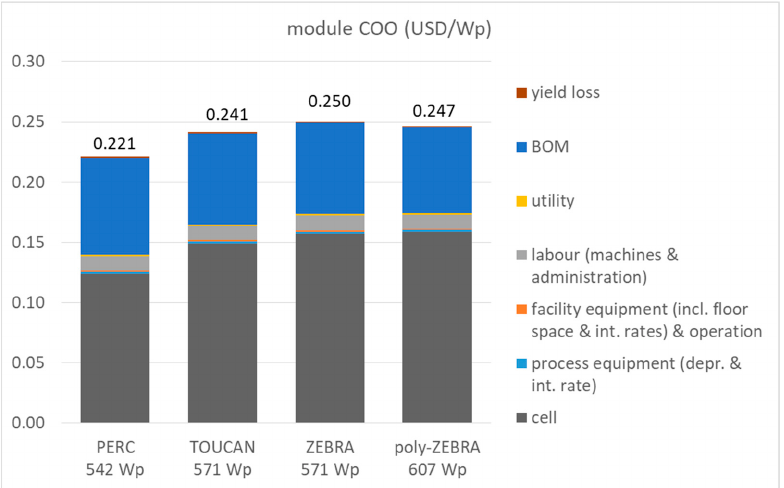
Figure 13. COO of different module technologies and Pmpp (Wp) at STC for a 144 half-cell module using the respective cell technologies.